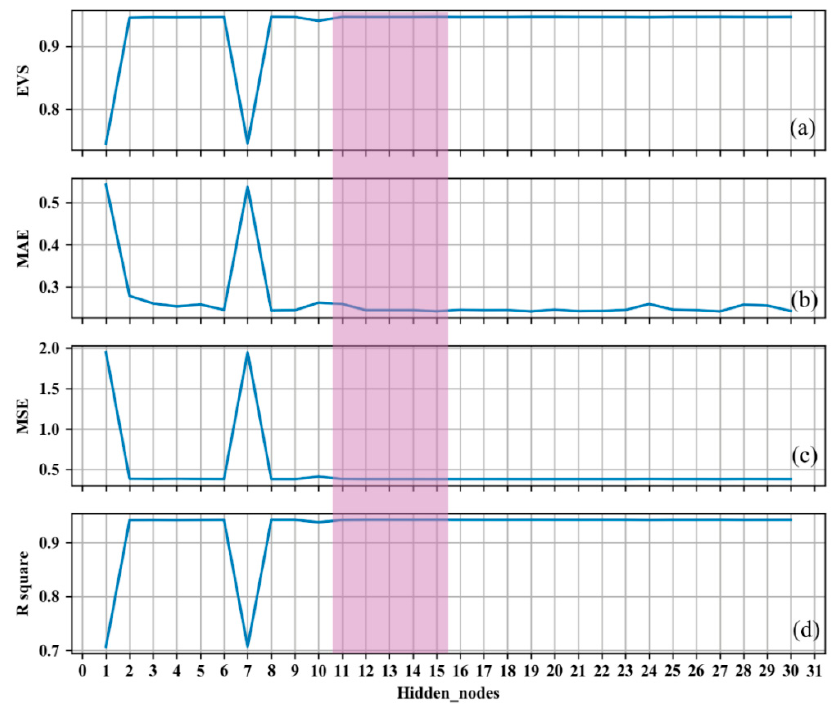
Figure 2. Comparison of the accuracy of different hidden-layer node models. The purple area is the relatively appropriate number of hidden layer nodes. ( a ) Variation of EVS with the increase in hidden nodes; ( b ) variation of MAE with the increase hidden nodes; ( c ) variation of MSE with the increase in hidden nodes; ( d ) variation of R 2 with the increase in hidden nodes.